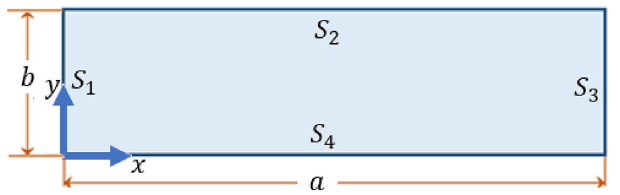
Figure 4. Schematic representation of the